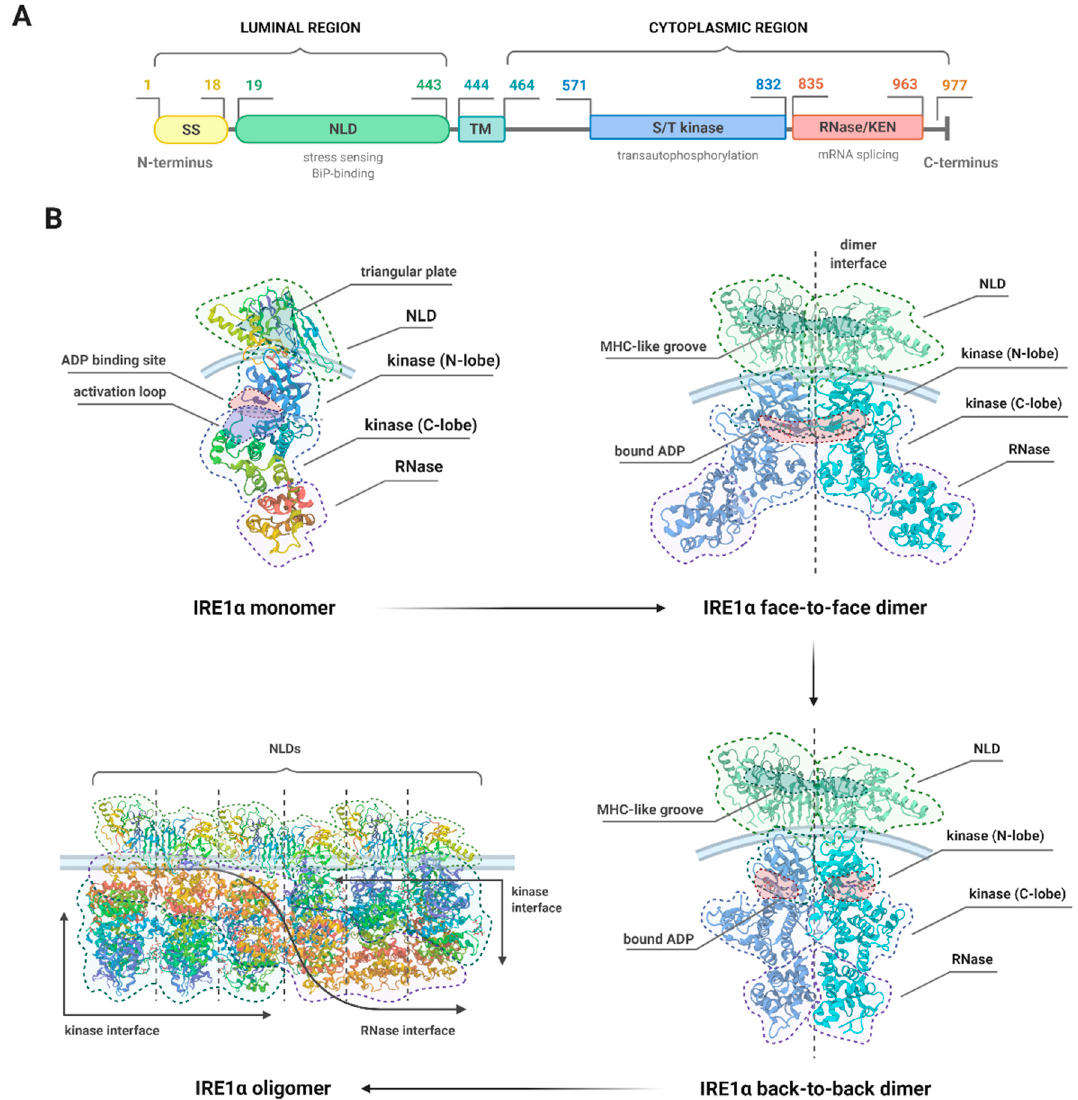
Figure 3. The molecular insight into the structure of human inositol-requiring enzyme type 1 α (IRE1 α ) ( A ) and the structural changes occurring upon its activation ( B ). ( A ) At the N-terminal end of IRE1 α molecule, there is an 18 amino acid signal sequence (SS) and the N-terminal luminal domain (NLD), consisting of three major β -sheets forming a triangular plate. Either the transmembrane region (TM) or the serine/threonine kinase (S/T kinase) and endoribonuclease (RNase) domains of the cytoplasmic region consist mostly of α -helices, and the RNase domain extends to the C-terminus of IRE1 α protein. ( B ) Upon activation, the luminal domains oligomerize, bringing the cytosolic kinase domains into juxtaposition, thus allowing for its trans-autophosphorylation and cofactor binding. This results in the activation of protein kinase, conformational change from “face-to-face” to “back-to-back”, and the subsequent induction of RNase activities within the cytoplasmic region. Activated IRE1 α dimers further oligomerize to form a complex structure of more than four molecules, in a characteristic rod-shaped assembly with the extensive RNase surface. PDB ID codes for the used models: NLD: 2HZ6; cytoplasmic region: 4Z7G (monomer), 3P23 (face-to-face dimer), 2RIO (back-to-back dimer), 3FBV (oligomer). Notably, XBP1 pre-mRNA is also translated into a functional protein XBP1u, a nega-